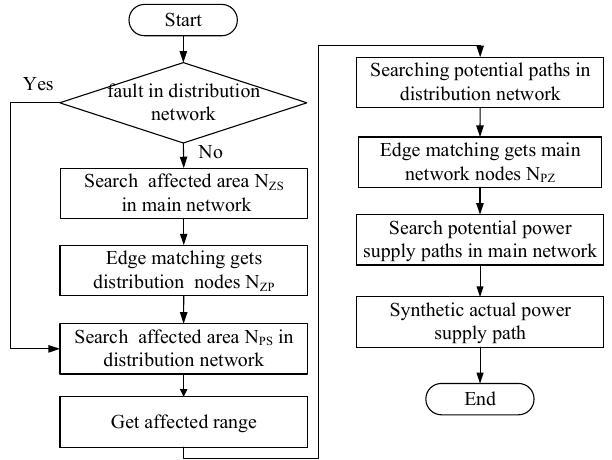
Figure 5. Power supply path search strategy.